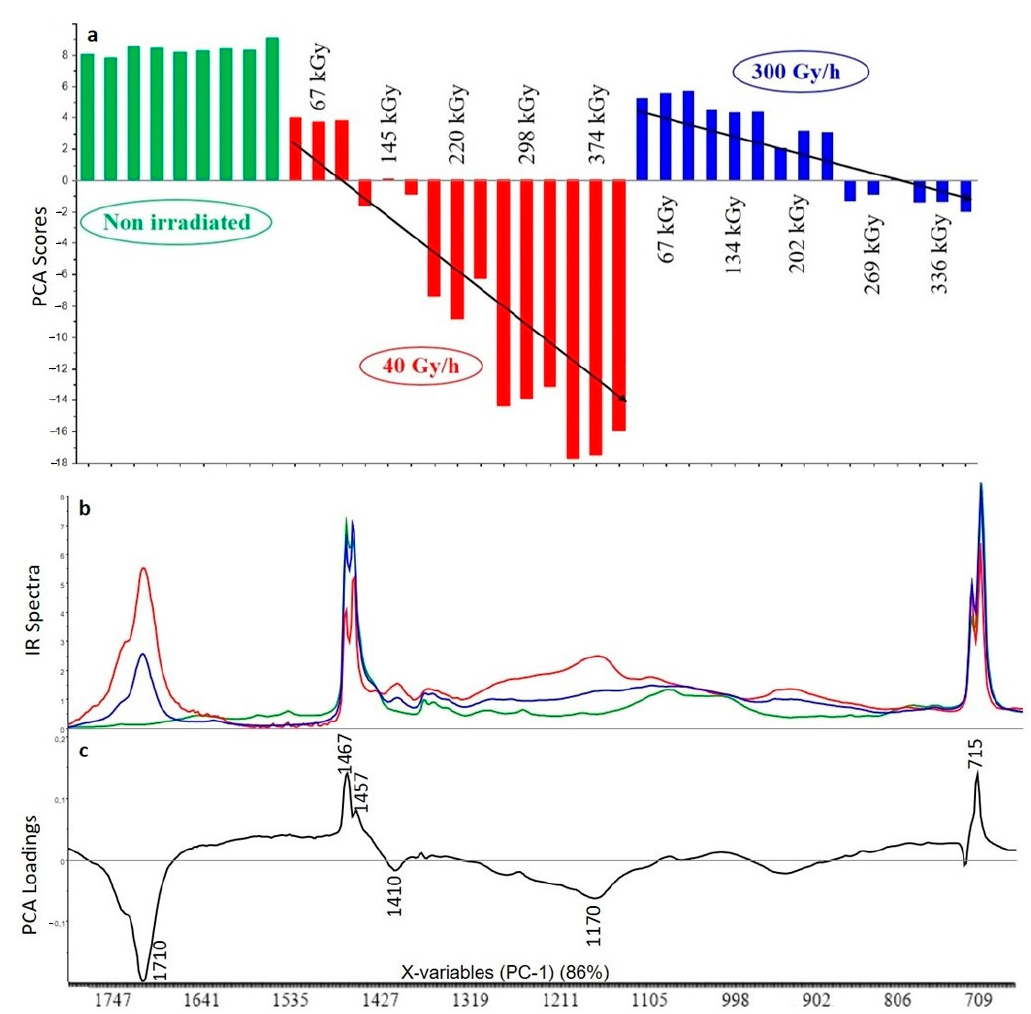
Figure 3. Principal component analysis (PCA) scores ( a ), FTIR spectra for highest dose ( b ) and PCA loadings ( c ) of the first principal component (PC1) for the analysis of XLPE polymer without additive (green: unaged samples, red: samples irradiated at 40 Gy/h, blue: samples irradiated at 300 Gy/h).